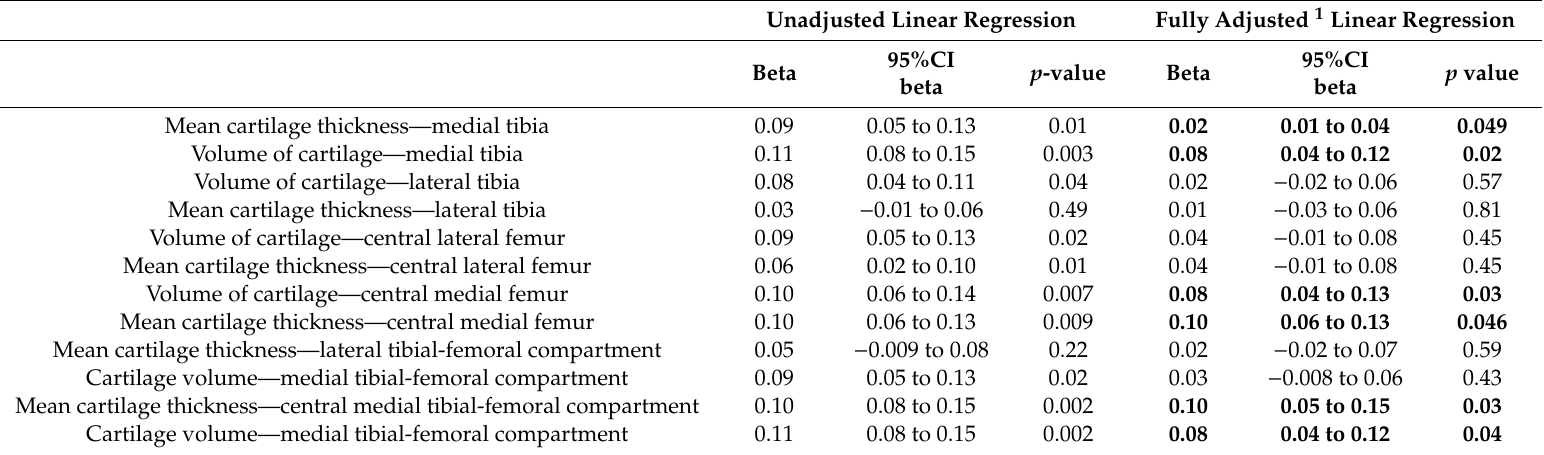
Table 2. Association between dietary magnesium intake and magnetic resonance